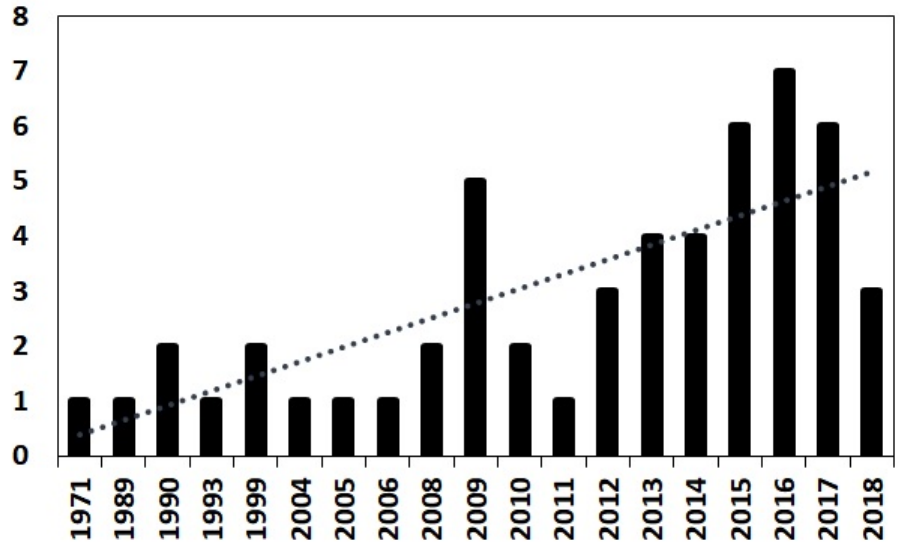
Figure 1. Number of published papers on bird-window collisions over